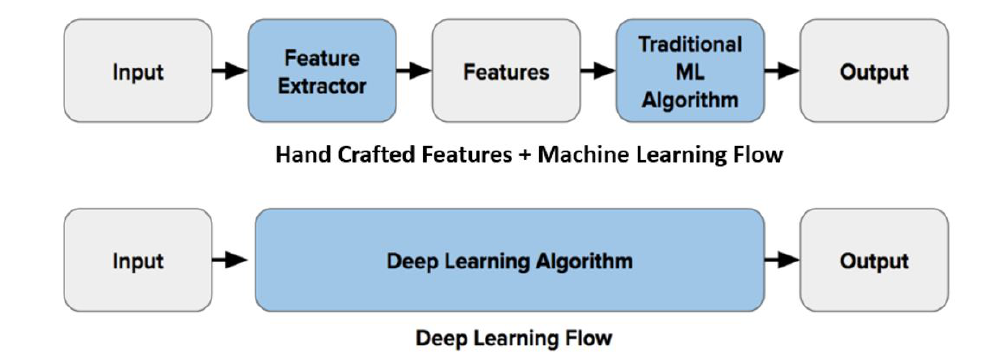
Figure 1. Different categories of vision-based